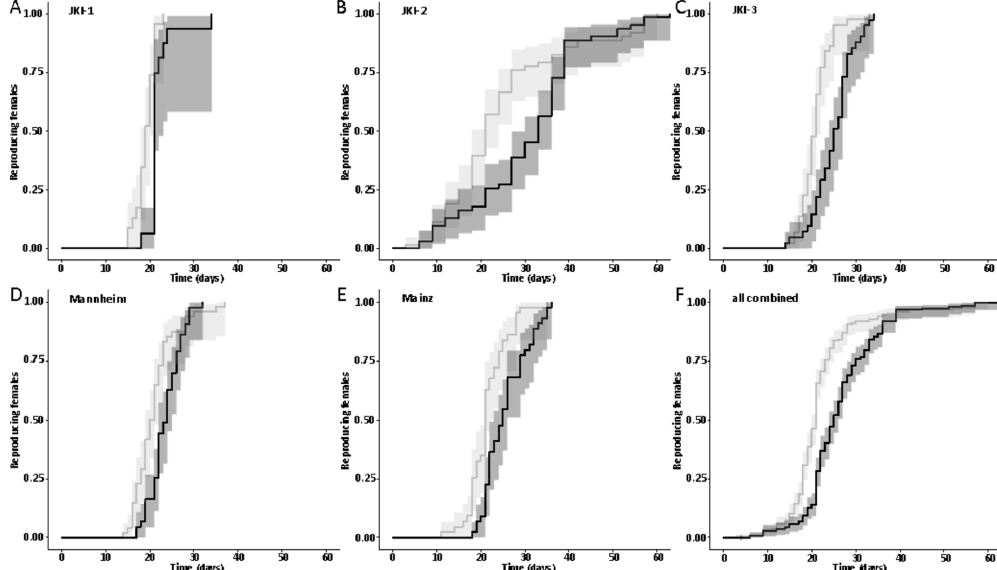
Figure 5. Influence of symbionts on the onset of reproduction in different O. surinamensis lines (( A – C ) JKI, ( D ) Mannheim, ( E ) Mainz). Symbionts in the JKI line were eliminated three times independently, resulting in lines JKI-1, JKI-2, and JKI-3. Experiments with these lines were conducted at different times, in different incubators; experiments with lines Mannheim and Mainz were conducted at the same time as JKI-3. ( F ) Overall, aposymbiotic females (grey lines and light grey, 95% confidence intervals) started to reproduce significantly earlier than symbiotic females (black lines and dark grey, 95% confidence intervals; Cox regression: p < 0.05). The same result was observed in all single experiments (Cox regression: p < 0.05) except JKI-2 (( B ) p = 0.306), where the majority of aposymbiotic females started earlier than symbiotic ones, but symbiotic ones started to ‘catch up’ towards the end of the experiment.